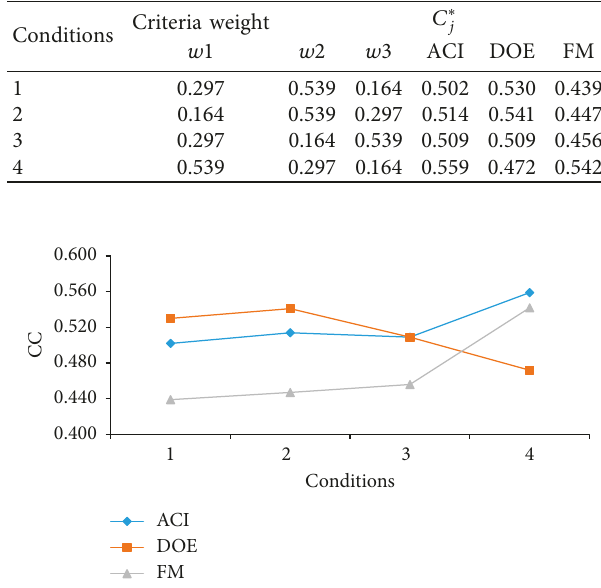
Table 2: Final score obtained by TOPSIS. Table 3: Sensitivity analysis output.